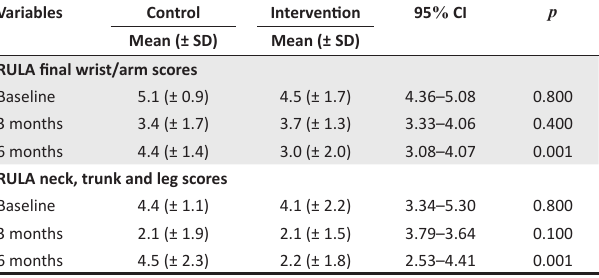
TABLE 4: Rapid upper limb assessment scores between the control and intervention group at baseline, 3 months and over a period of 6 months ( n = 127).